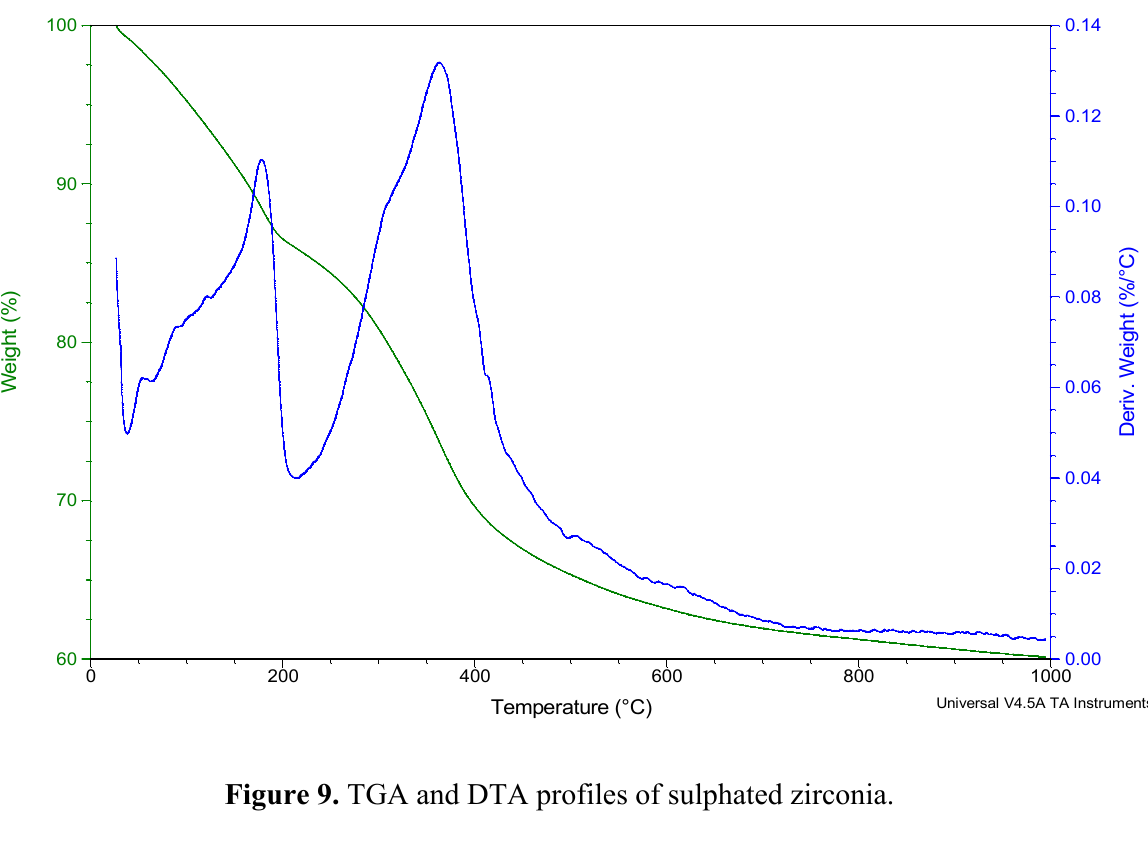
Figure 8. TGA and DTA profiles of HTs.